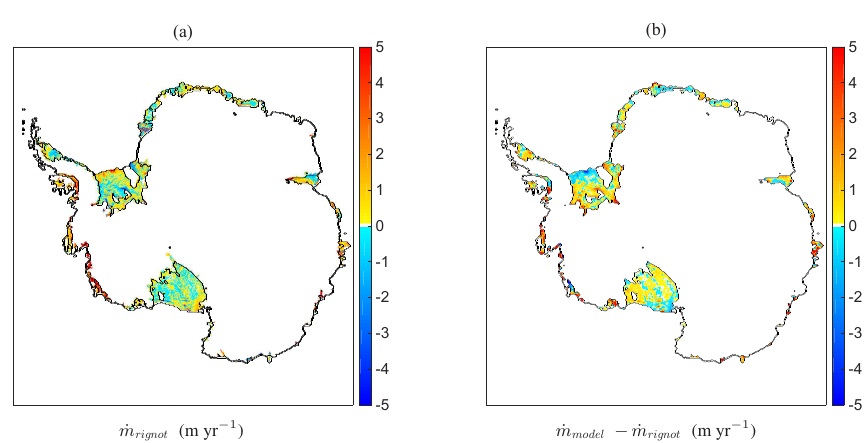
Figure 11. Basal melt rates in metres per year extracted from the Rignot et al. (2013) observational dataset (courtesy of Dr. Jeremie Moug- inot): (a) raw data plotted together with the currently used mask; (b) difference between the plume parametrization (Fig. 9a) and the obser- vations interpolated on the 20km grid.